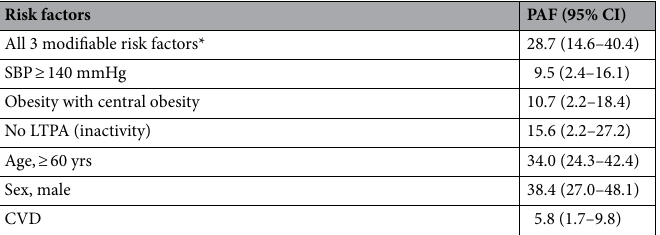
Risk factors PAF (95%